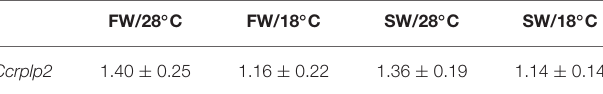
TABLE 3 | The 1 Ct value of mRNA expression of Ccrplp2 in liver